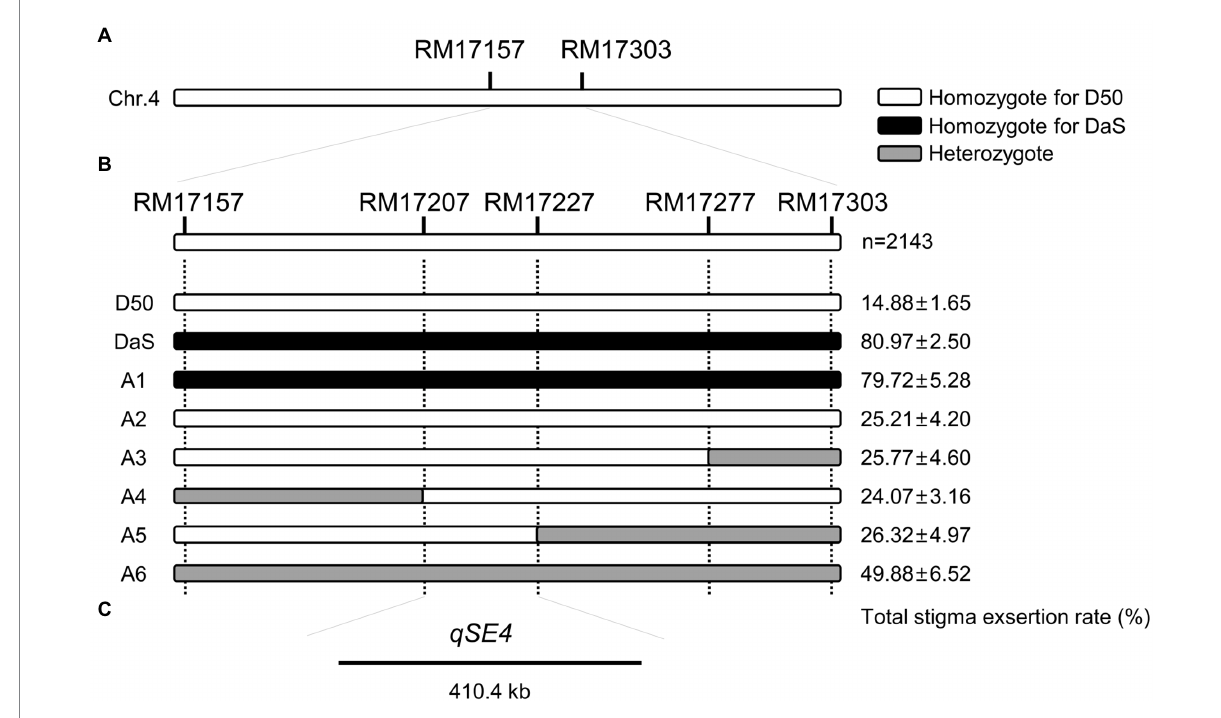
FIGURE 3 Fine mapping of qSE4 . (A) qSE4 is located between chromosome 4 markers RM17157 and RM17303. (B) Genotype and phenotype of D50, DaS and six recombinant individuals (A1–A6). The data represent the mean values ± SD ( n = 6). (C) qSE4 was fine mapped within 410.4 Kb between markers RM17207 and RM17227.